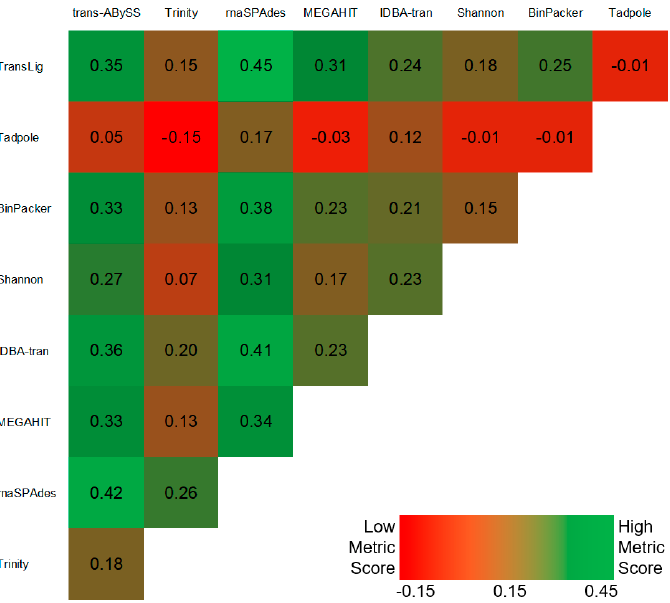
Figure 4. Bi-assembly assessment scores. Heatmap of bi-assembly assessment scores from 36 combinations of 9 assemblers compared to MEGAHIT single-assembly as a baseline score (0). Scores lower than 0 underperformed when compared to MEGAHIT single-assembly, whereas, scores higher than 0 overperformed. Green denotes a higher assessment score and red denotes a lower assessment score among the 36 bi-assembly groups. Shannon denotes Shannon Cpp version. 3.5. Tri-Assembly We observed the highest possible AAS of 0.50 in a tri-assembly approach containing Trans-ABySS, rnaSPAdes and TransLig (Figure 5). The higher AAS values are primarily located in the highest performing assembler groups: Trans-ABySS, rnaSPAdes, and Trans- Lig (Figure 5). The lower AAS values are found not only in the negative control Tadpole,